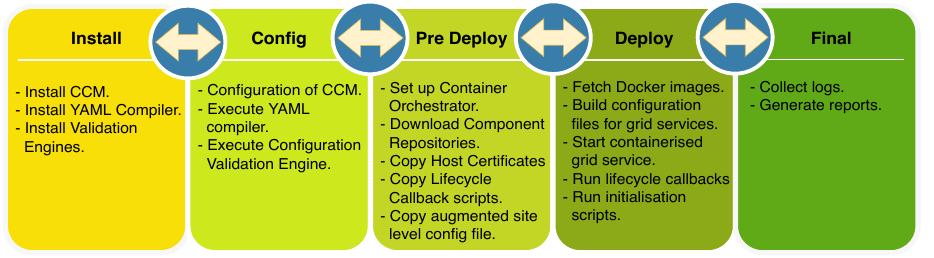
Figure 1: The stages in the Execution Pipeline of the SIMPLE